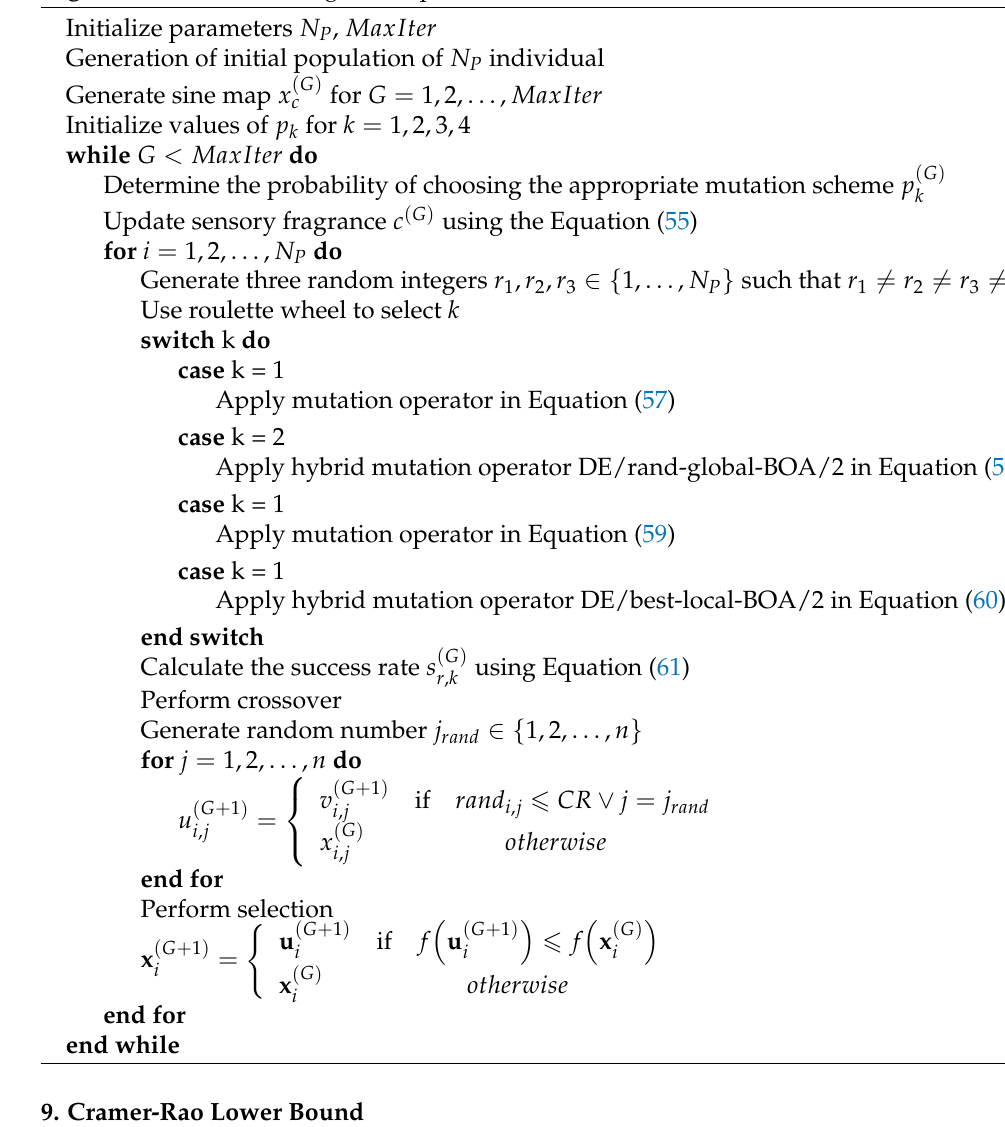
Algorithm 1 ICDEBOA algorithm